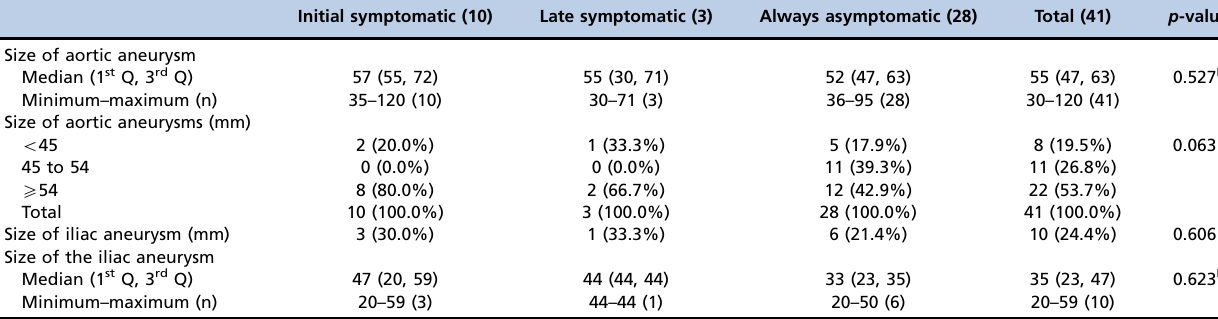
A: Comparison by ANOVA. Other comparisons by Fisher ’ s exact test. SD: Standard deviation. Table 2 - Sizes of aortic and iliac aneurysms. Initial symptomatic (10)